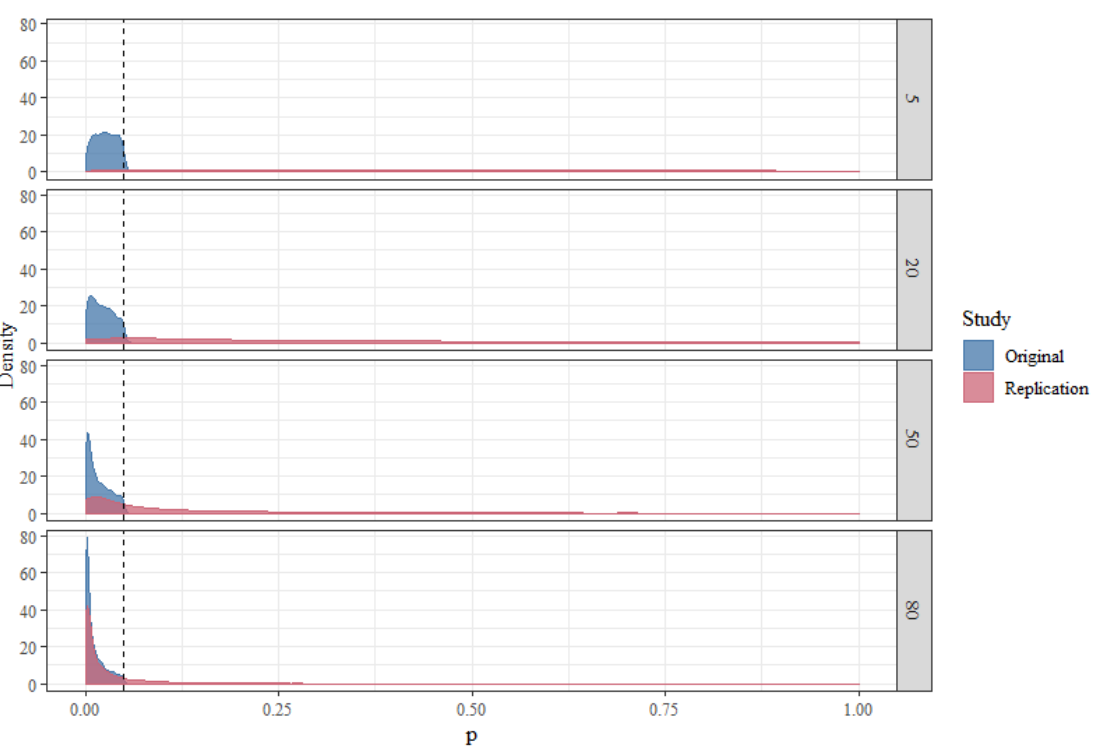
Figure A2 . Density distributions of the p -values from the first simulation study. Blue plots represent the p -value distribution of the original studies, which all fall below .05 due to a simulated publication bias. Red plots represent the p -value distribution of the exact replication studies. The four plots are arranged by the power of the studies, from 5% at the uppermost panel, to 20%, 50% and 80% at the lowermost